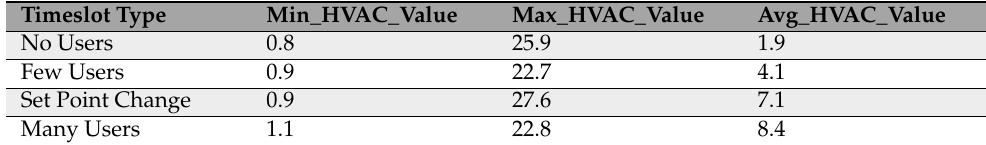
Table 3. HVAC consumption with respect to timeslot type.